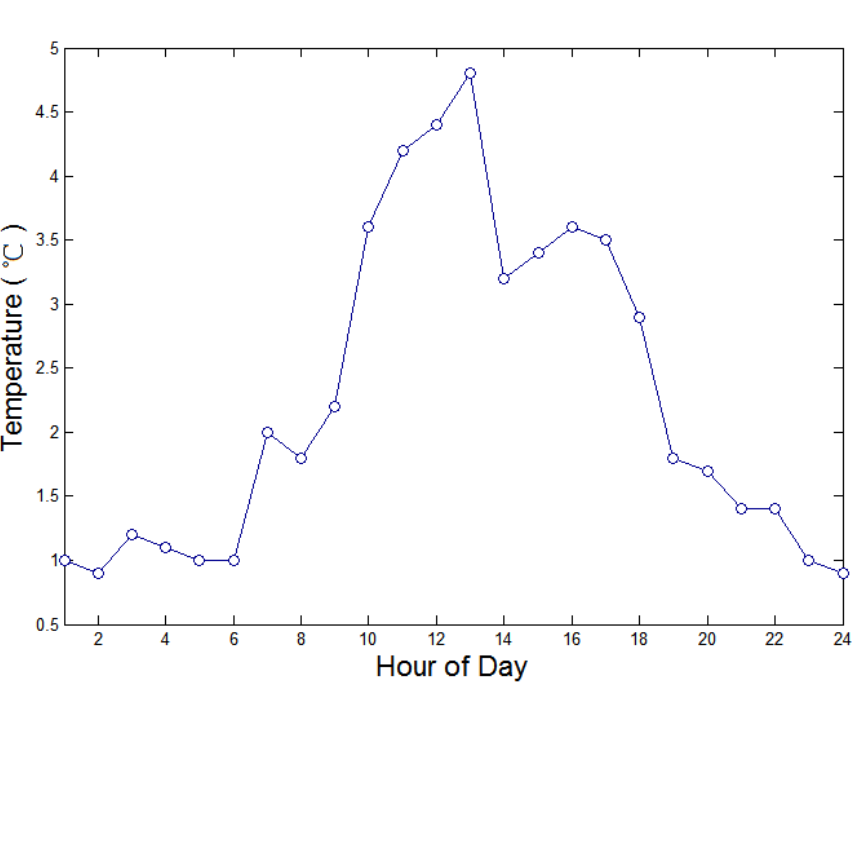
Figure 10. Daily temperature